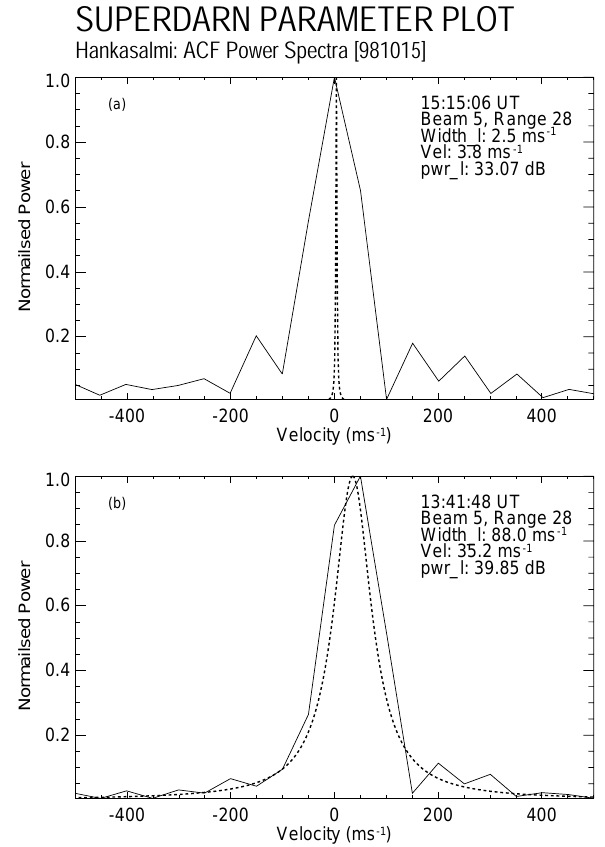
Fig. 5. CUTLASS velocity spectra for range 28 of beam 5 of the Finland radar 15 October 1998: (a) Normal narrow spectral widths associated with artificial scatter taken at 15:15:06UT and (b) in- creased spectral widths coincident with Pc4 wave activity observed inside the patch of artificial scatter at 13:41:48UT. The solid lines represent the low resolution spectrum derived from the FFT of the measured ACF and the dashed curves are Lorentzian profiles gener- ated using the parameters calculated by the ACF fitting programme,